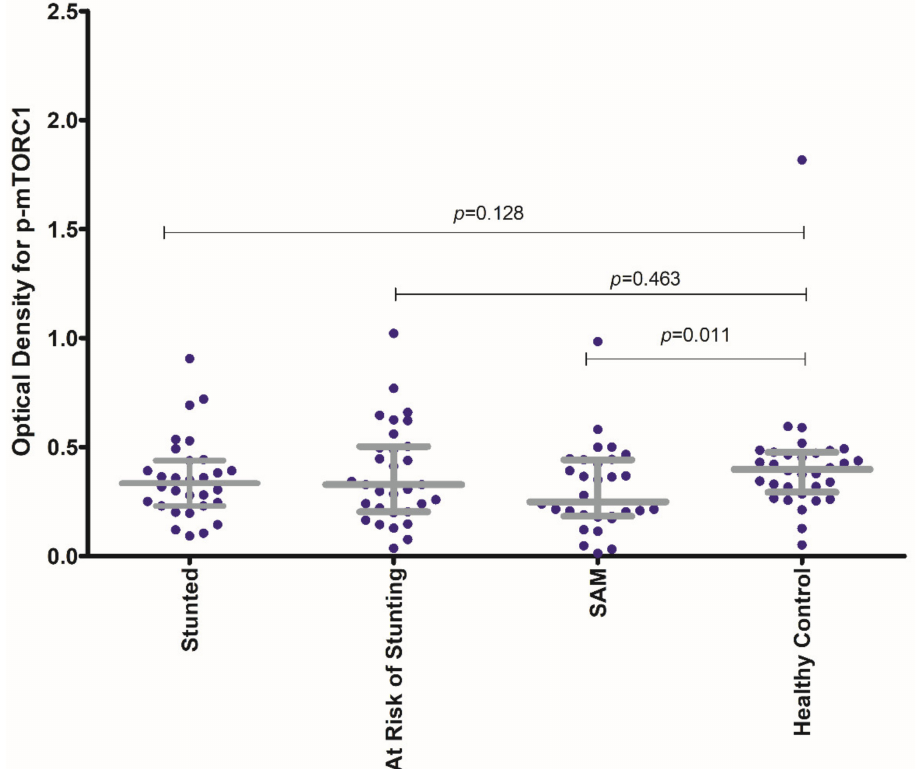
Figure 2. Comparison of the activity of phospho-mTORC1 (as expressed by the OD for phospho- mTORC1 at 450 nm) for each of the malnourished study arms (stunted, at risk of stunting and SAM) with that of the healthy control group. The p -value shown is the result of the Mann–Whitney U test comparing the median OD value for p-MTORC1 of each of the malnourished groups (stunted, at risk of stunting, SAM) with that of the healthy control group. The colored dots represent the individual OD values for p-mTORC1 at 450